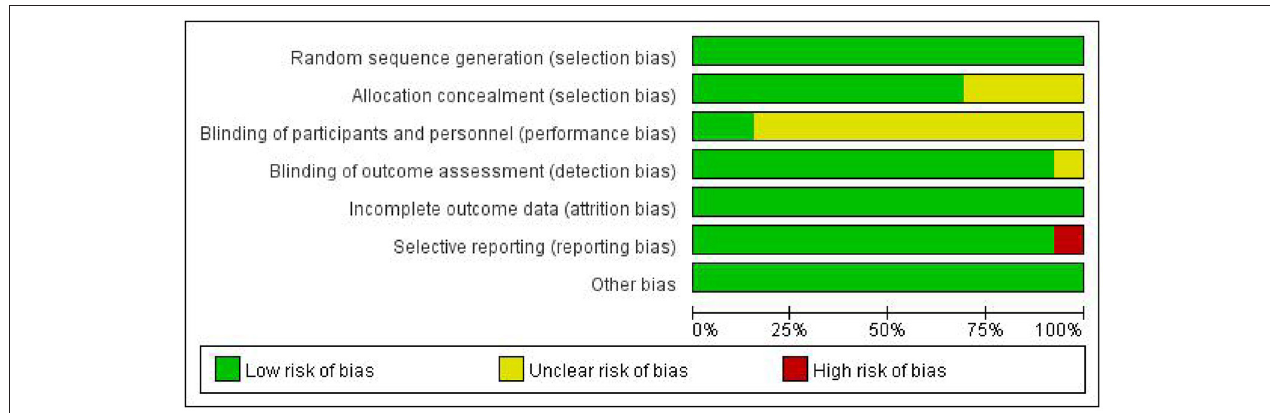
FIGURE 2 | Risk of bias